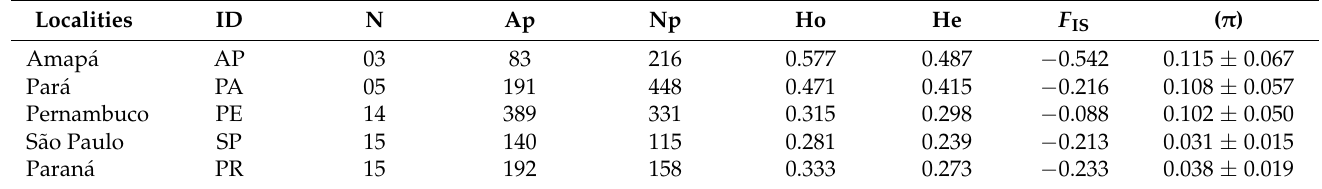
Table 1. Genetic diversity statistics for Pseudobatos percellens using 3.329 SNPs. ID: sampling